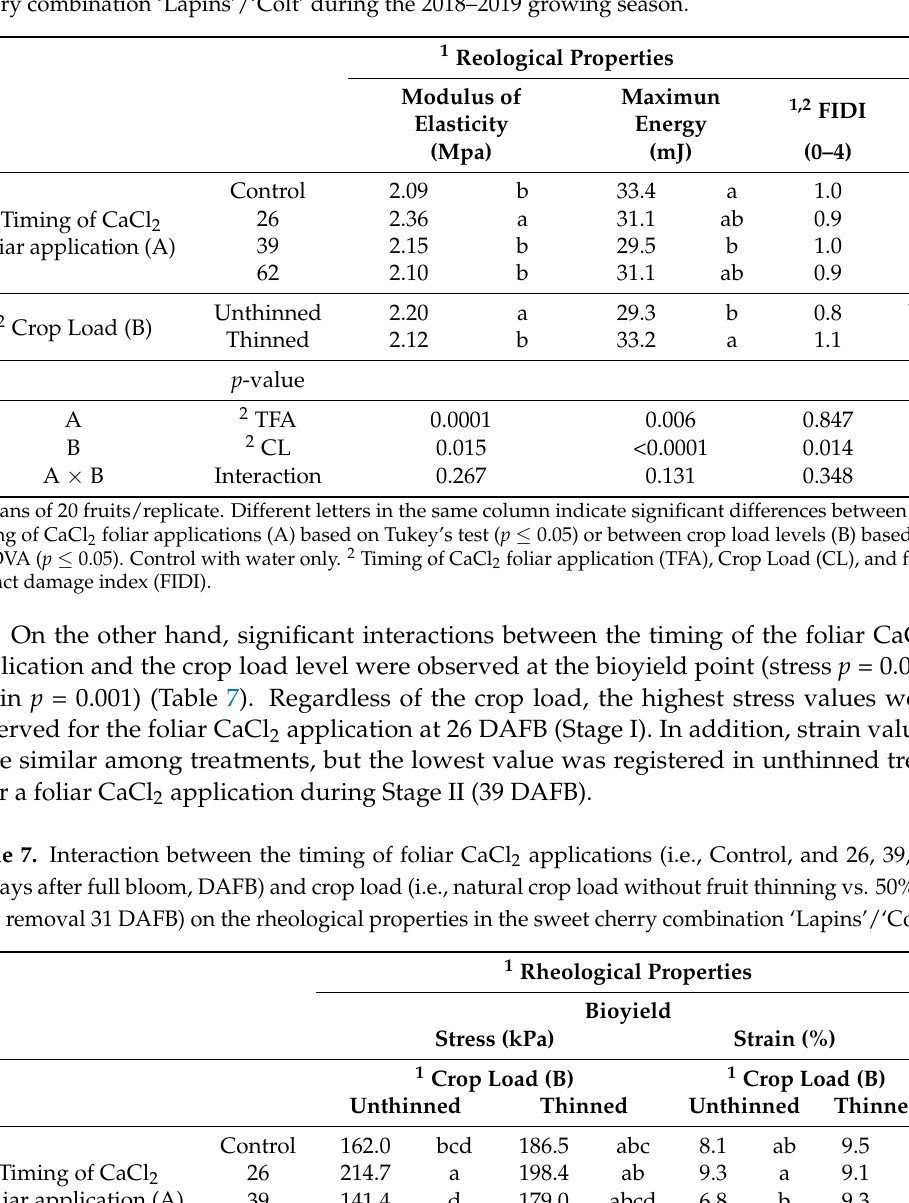
Table 6. Effect of the timing of foliar CaCl 2 applications (i.e., Control, and 26, 39, and 62 days after full bloom, DAFB) and crop load (i.e., natural crop load without fruit thinning; and 50% of fruit removal by hand, 31 DAFB) on the modulus of elasticity and fruit impact damage index in the sweet cherry combination ‘Lapins’/‘Colt’ during the 2018–2019 growing season.